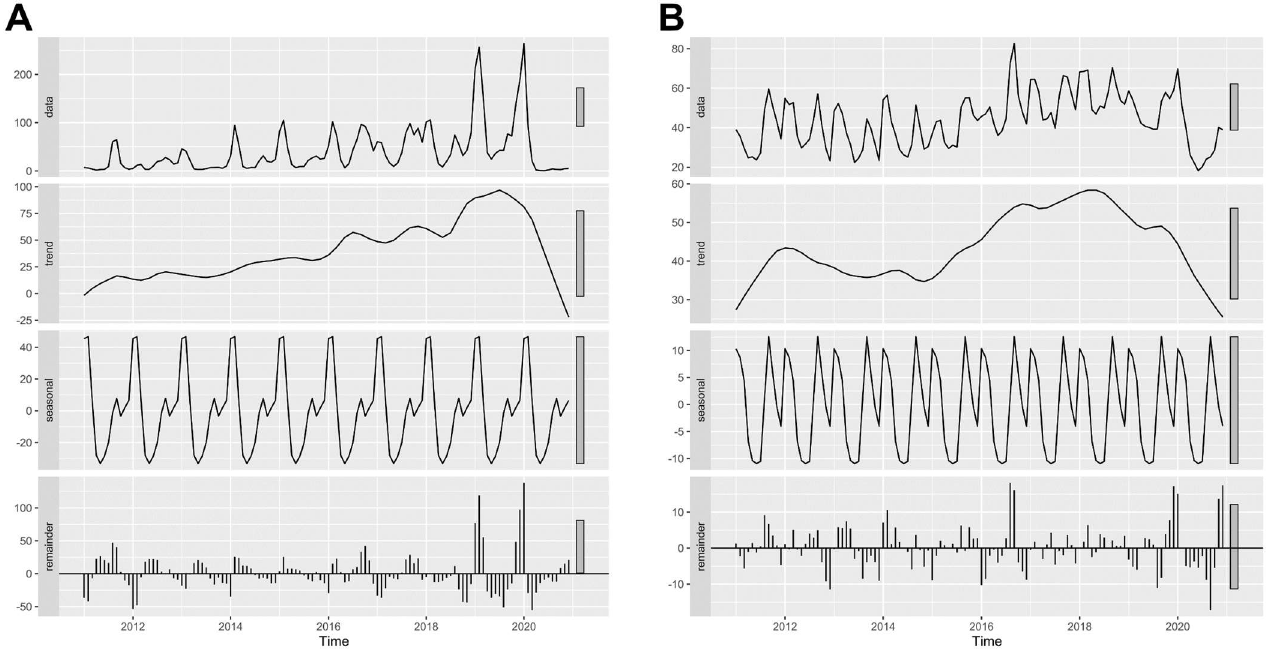
Figure 2. Seasonal-trend decomposition using loess (STL) plots of ( A ) influenza and ( B ) pneumonia in Chiang Mai from 2011 to 2020. A data column of the plot showed the original data of the monthly incidence rate, which were decomposed to trend, seasonal, and remainder plots.